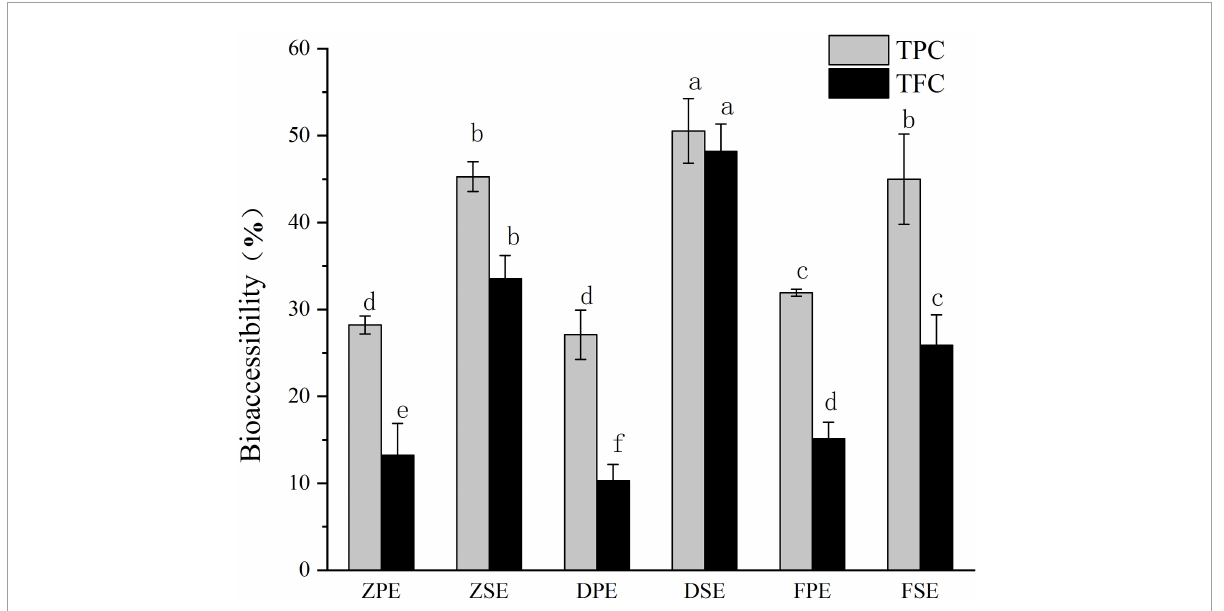
FIGURE5 The bioaccessibility of polyphenols and flavonoids in Kadsura coccineas fruits after simulated in vitro digestion. Values are presented as means ± SD ( n = 3), ( p < 0.05). ZPE, Zihei peel extract; DPE, Dahong peel extract; FPE, Fenhong peel extract; ZSE, Zihei sarcocarp extract, DSE, Dahong sarcocarp extract; FSE, Fenhong sarcocarp